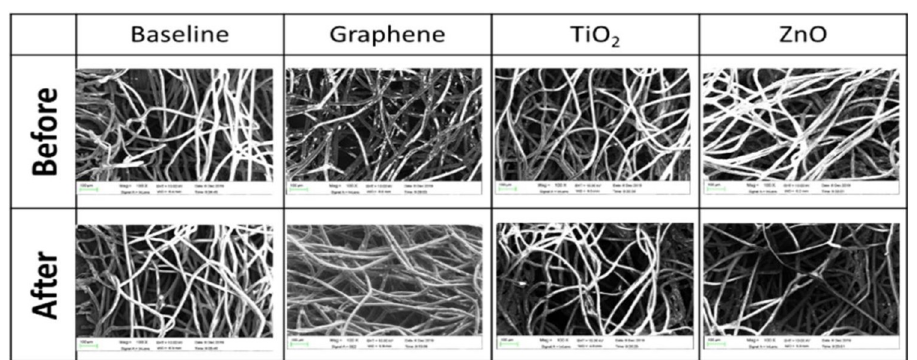
Fig 2. Scanning Electron Microscope (SEM) images of uncoated and coated masks, before and after exposure to PM 2.5 particles. The ‘before’ images confirm the adhesion of the nanoparticles to the fibers of the filtration media. The ‘after’ images demonstrate the adsorption of the PM 2.5 particles onto the nanoparticles and the